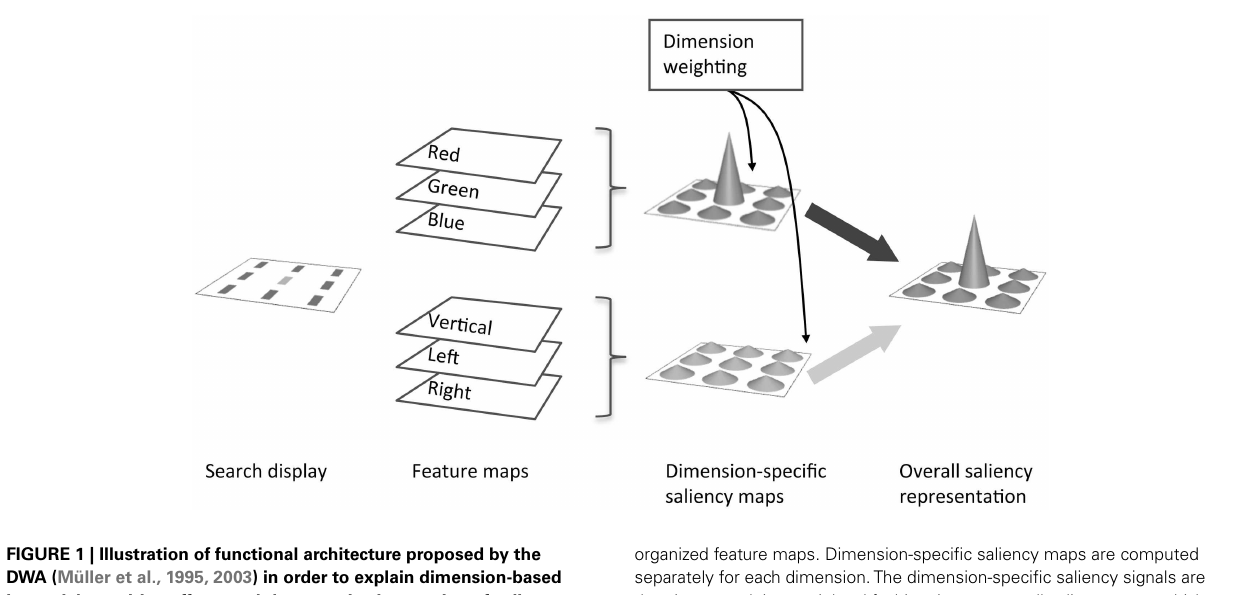
FIGURE 1 | Illustration of functional architecture proposed by the DWA (Müller et al., 1995, 2003) in order to explain dimension-based inter-trial transition effects and the co-active integration of saliency activation in search for dimensionally redundant feature singleton targets. The search display contains a target differing from distractors by color.Target and distractor features are registered in dimensionally